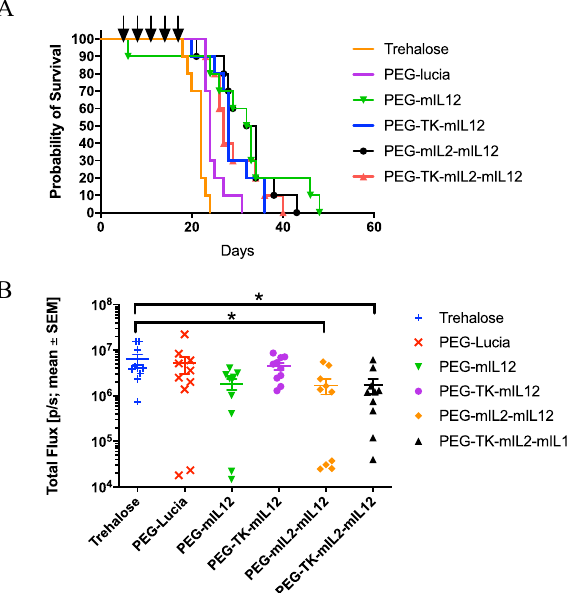
Figure 5. Activity of l-PEI/DNA nanoparticles in a B16F10 syngeneic, metastatic model of cancer in the lungs in C57BL/6 mice represented by a Kaplan Meier survival plot. Mice were inoculated intravenously via the tail vein with B16F10-Red-FLuc murine melanoma cells and treated with nanoparticles at 3-d intervals, beginning at Day 5 (post tumor cell inoculation) as indicated by the arrows above the plot. Nanoparticle formulations of plasmids PEG-mIL12 (green line, filled upturned triangle), PEG-TK-mIL12, PEG-mIL2-mIL12, PEG- TK-mIL2-mIL12 significantly extended survival ( p ≤ 0.01, Log-rank test) of the mice compared to vehicle control and PEG-lucia ( p ≤ 0.01, Log-rank test) ( A ). PEG-lucia also significantly extended survival in this study compared to the vehicle control ( p ≤ 0.05, Log-rank test). Plot of the mean in vivo luminescence signal ± SEM (Total Flux (p/s)) in the lungs of C57BL/6 mice at 12 d after inoculation of B16F10-Red-FLuc cells showed a significant reduction in signal between PEG-mIL2-mIL12 and the vehicle control group, and PEG-TK-mIL2- mIL12 and the vehicle control group ( p ≤ 0.05, Dunnett’s multiple comparisons test) ( B